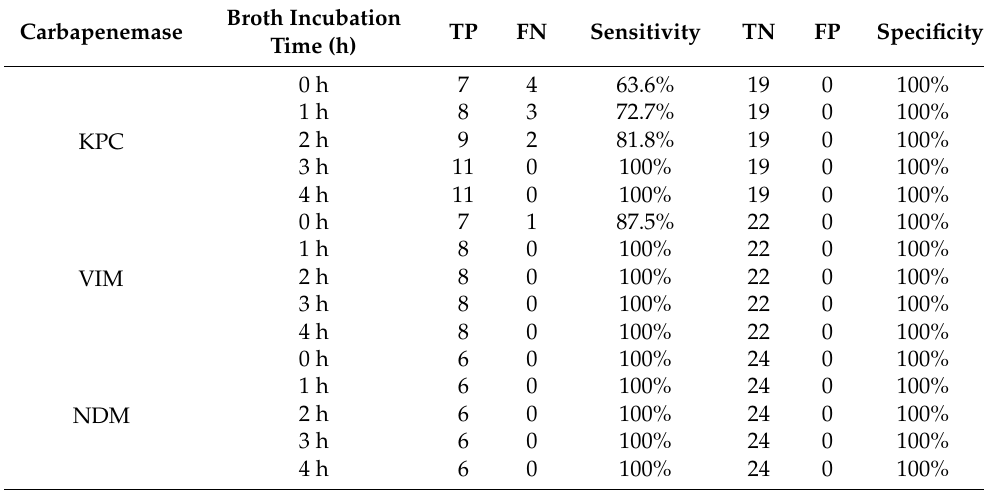
Table 2. Performance of the NG-Test CARBA 5 directly from rectal swabs compared to PCR.